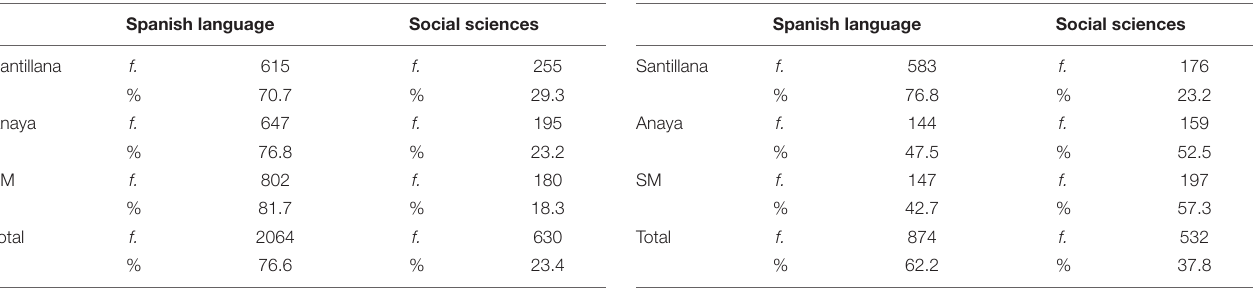
TABLE 3 | Levels of cognitive-reading progress (N1 – literal literacy). TABLE 4 | Levels of cognitive-reading progress (N2 – inferential